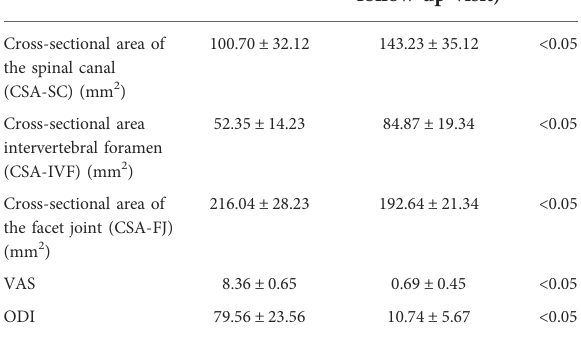
TABLE 2 Morphometric of MRI and clinical outcomes. P Preoperative Postoperative (last follow-up visit) Cross-sectional area of the spinal